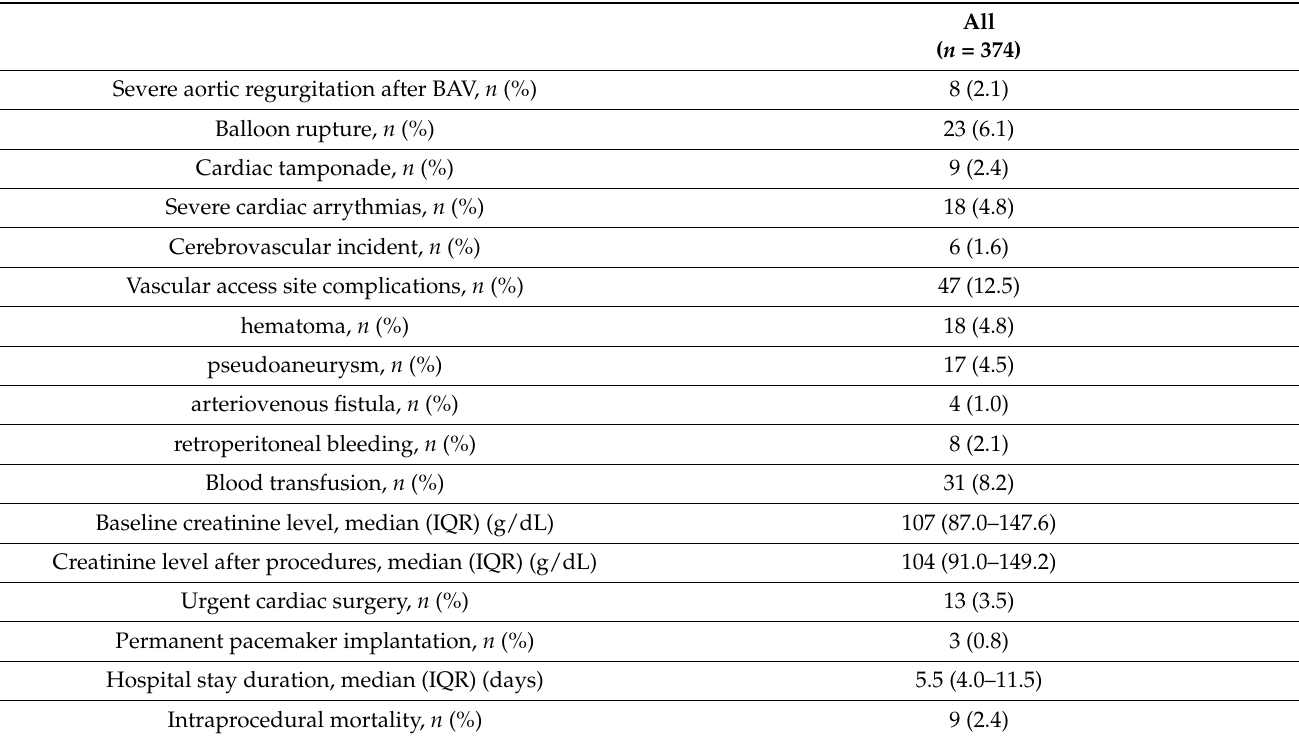
Table 4. Complications.